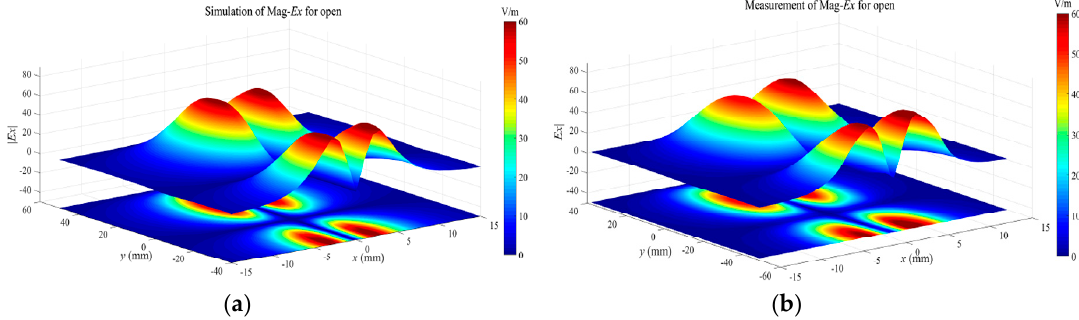
Figure 22. ( a ) The simulated and ( b ) measured Ex-field distributions at the height of 2 mm over the